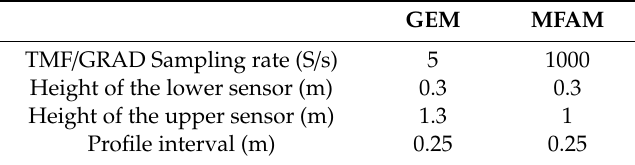
Table 6. Acquisition parameters of the Geomagnetic Surveys (GM) survey.